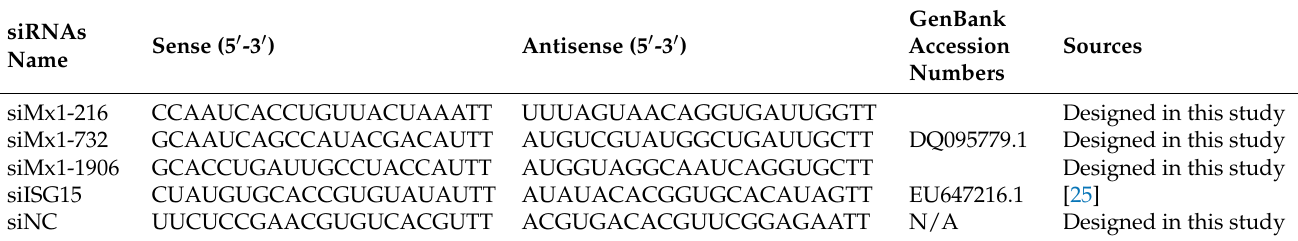
Table 2. The specific and scrambled siRNAs used for the knockdown of Mx1 and ISG15 proteins in PK-15